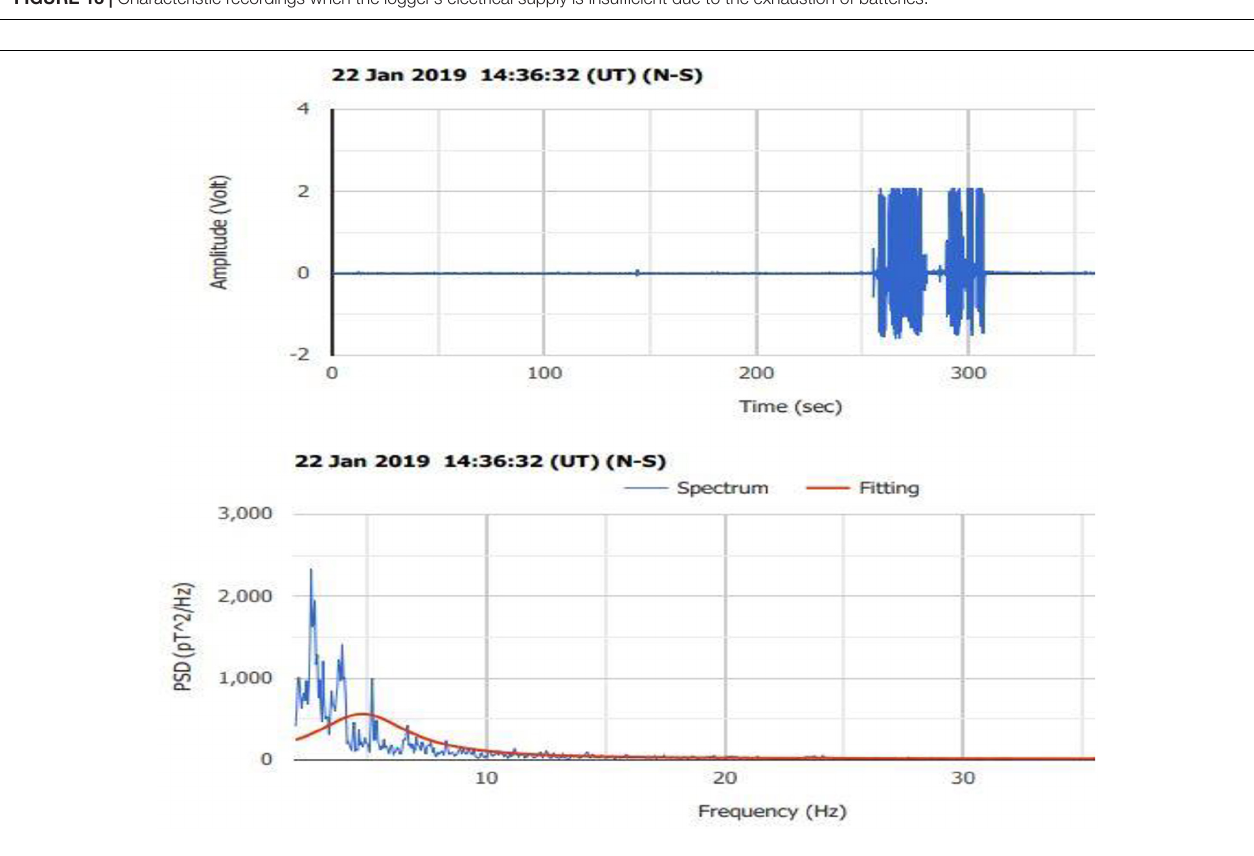
FIGURE 13 | Characteristic recordings when the logger’s electrical supply is insufficient due to the exhaustion of batteries.